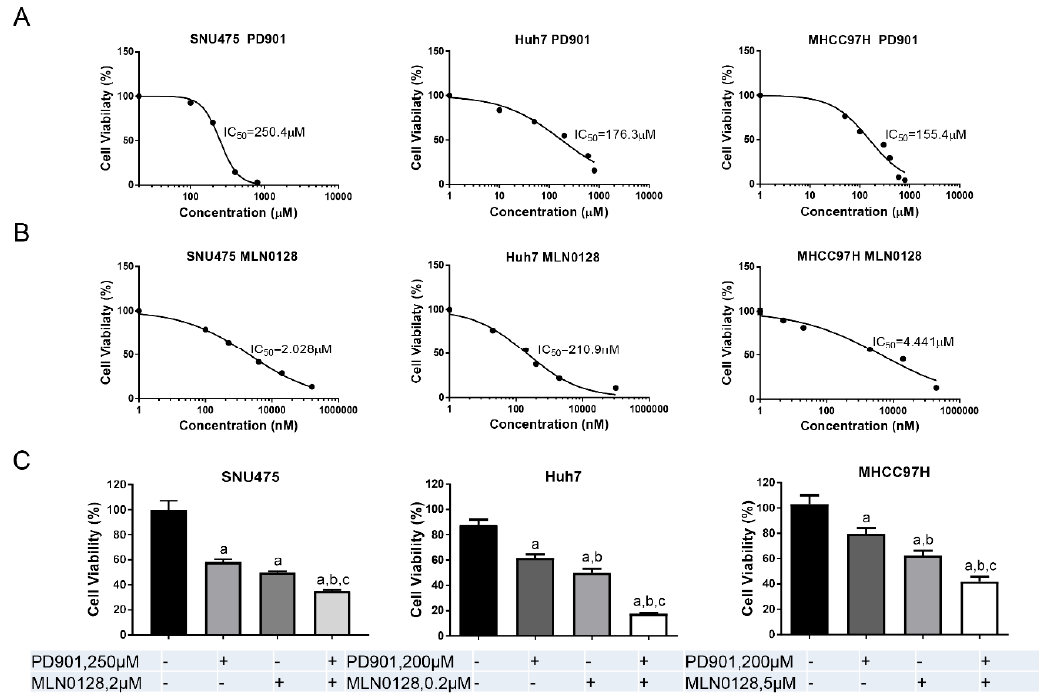
Figure 3. PD901 and MLN0128 inhibit HCC cell growth in vitro. ( A , B ) IC 50 values calculated by quantifying the Crystal violet staining from a panel of HCC cell lines treated for 3 days with the indicated doses of PD901 ( A ) and MLN0128 ( B ). ( C ) Combining PD901 with MLN0128 (around IC 50 concentration) resulted in a significantly reduced cell viability in HCC cell lines compared